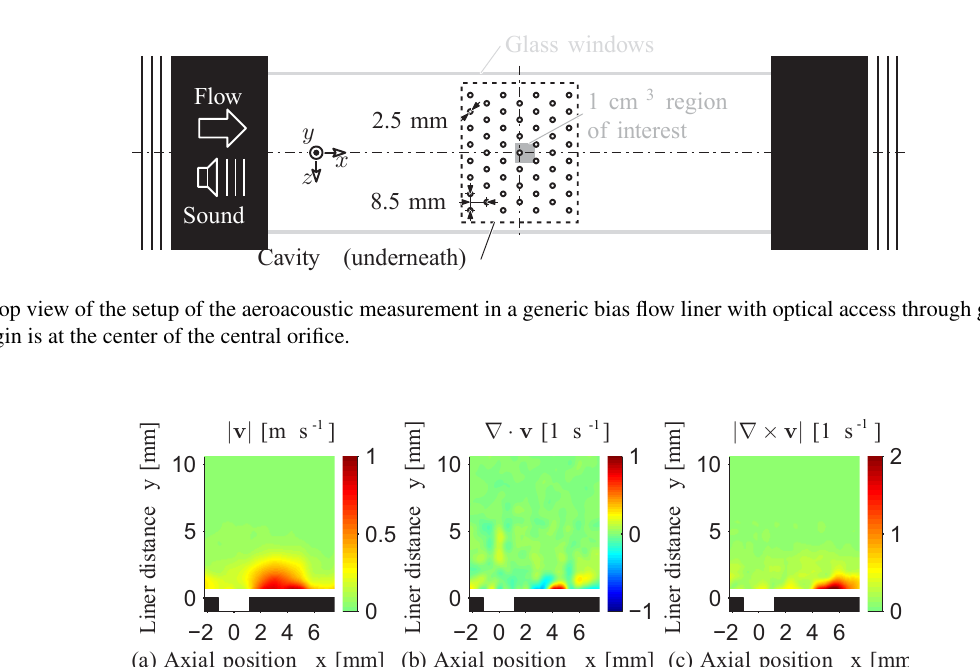
5 kgh − 1 is fed into the cavity. This value corresponds to